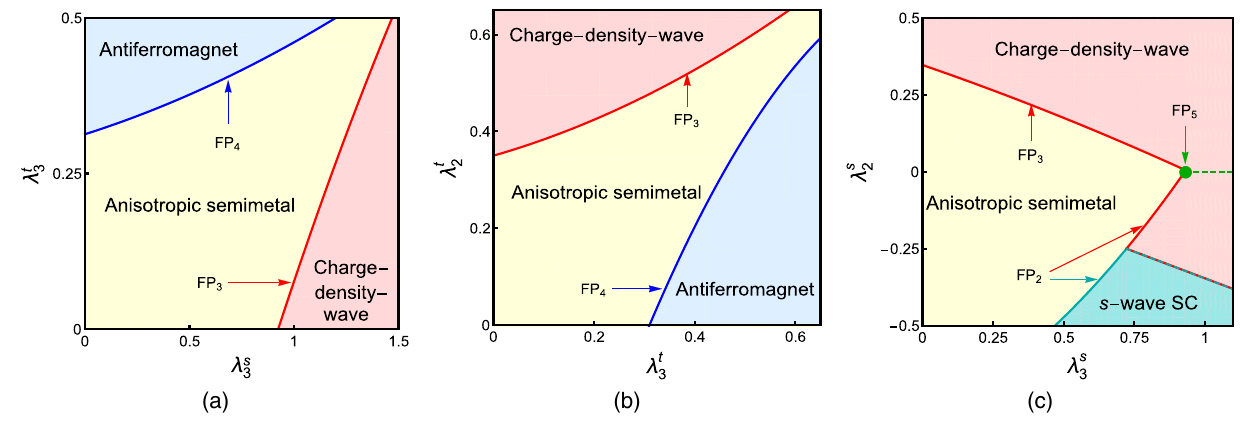
FIG. 12. Various cuts of the phase diagram for the spin- 1 /2 interacting ASM, residing at the QCP between the two-dimensional Dirac semimetal and the band insulator. These phase diagrams are obtained for n ¼ 10 , which parametrically keeps the quantum fluctuations ’ s; see beyond one dimension small. All coupling constants are dimensionless and measured in units of ϵ . Various fixed points (FP j Table IV) controlling the continuous quantum phase transition from the ASM to different broken-symmetry phases are displayed in each cut of the phase diagram. Note that FP 2 are interacting QCPs, while FP 5 is an interacting bicritical point [appearing at the point of ; 3 ; 4 inflection in panel (c), the green dot]. Along the dashed red/cyan line in (c), the CDWand s -wave SC simultaneously display long-range order, because of the pseudospin SU(2) symmetry. Below (above) this line, only s -wave SC (CDW) order is realized as true long-ranged order. The dashed green line is a crossover boundary, across which the short-range correlations of s -wave pairing vanish smoothly from bottom to top. While extracting the phase diagram in each two-dimensional coupling constant space, we set the bare value of the other two couplings to be